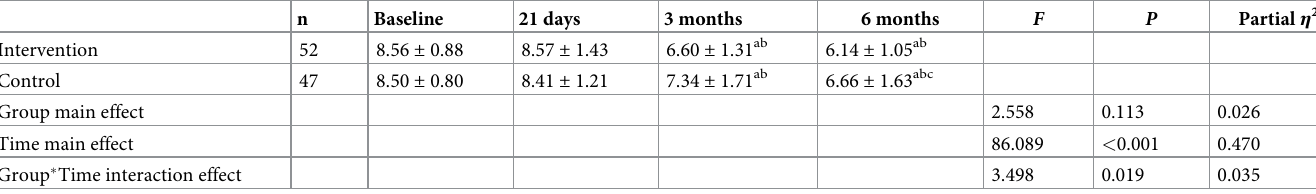
Compared with baseline, “a” indicates p < 0.05; compared with 21 days, “b” indicates p < 0.05; compared with the end of 3 months, “c” indicates p <